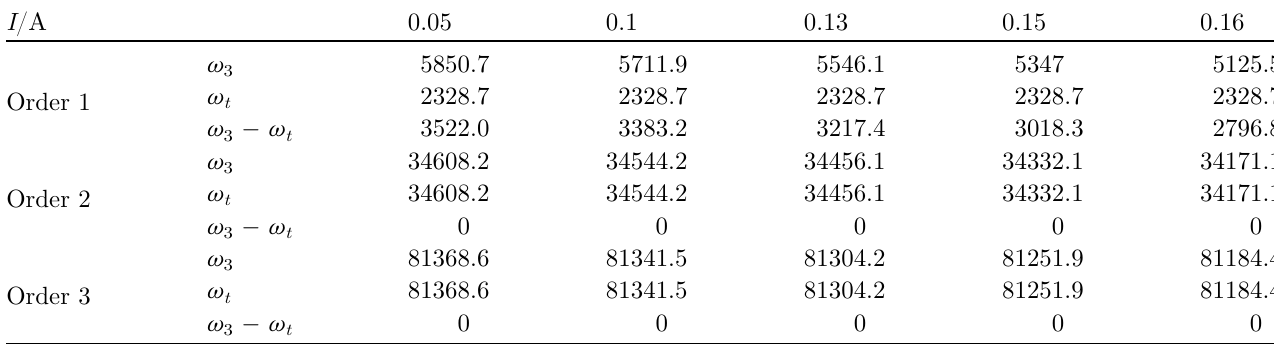
Table 8. Changes of natural frequency with I with and without friction force